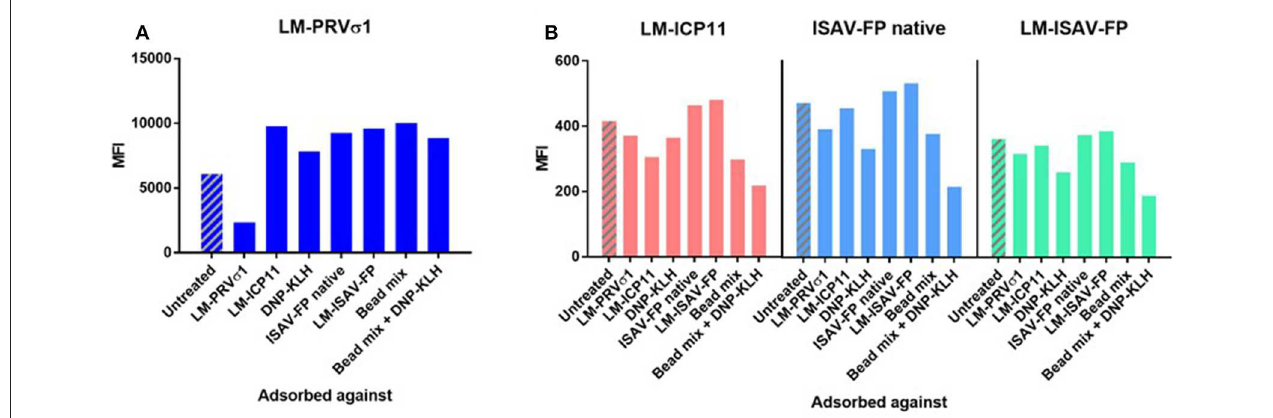
FIGURE 4 | Pre-adsorption of heat-treated pooled plasma from PRV-infected fish against antigens indicate specificity of anti-PRV σ 1 antibodies. Measured on beads coupled with (A) LM-PRV σ 1 and (B) non-PRV control proteins.